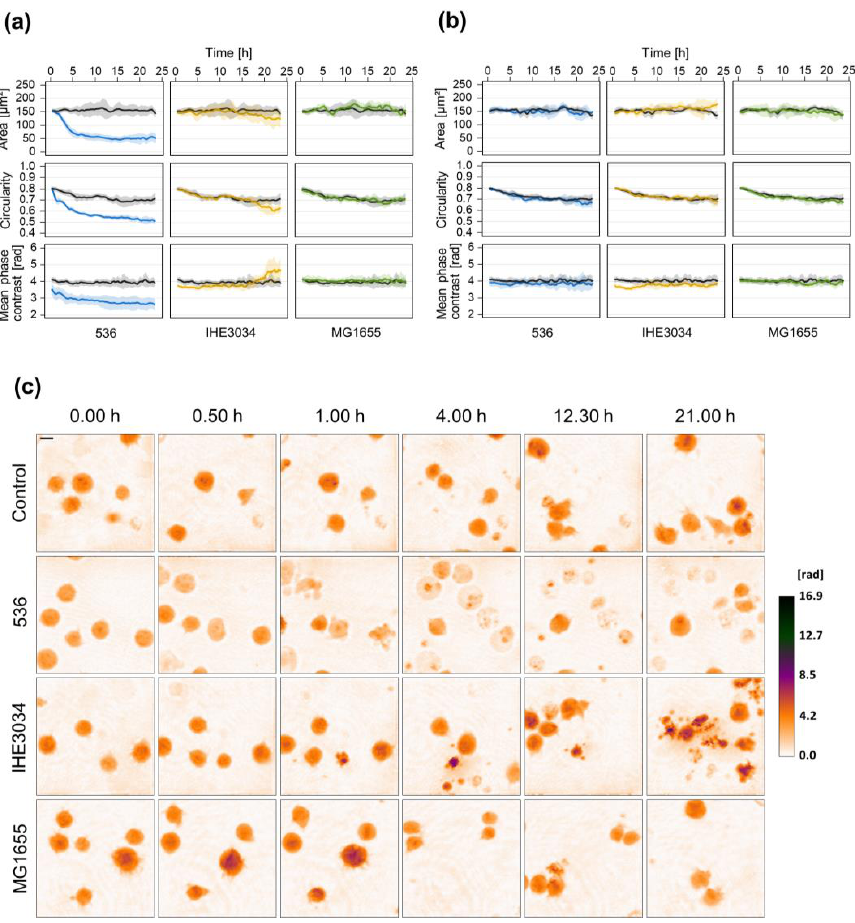
Figure 4. Culture supernatant but not MVs derived from different E. coli strains induce morphological changes in Jurkat cells. Jurkat cells were exposed to 25% ( v / v ) sterile culture supernatant ( a ) or 20 µ g/mL MVs ( b ) of different E. coli strains. Untreated cells served as control. Time-lapse ob- servation of morphological changes was carried out using DHM. ( a , b ) DHM quantitative phase contrast images were analyzed for the average single-cell area ( µ m 2 ), average circularity (AU), and mean phase contrast (rad) per cell. Results are shown as mean (lines) ± SD (shading) of at least three independent experiments. Controls are presented in black while different colors designate the individual strains. For better visualization, curves were smoothed using moving averages with a window size of 15 measuring points. ( c ) Representative color-coded phase contrast images of Jurkat cells at indicated time points after the addition of E. coli culture supernatant. The scale bar corresponds to 10 µ m. The calibration bar indicates phase contrast values in